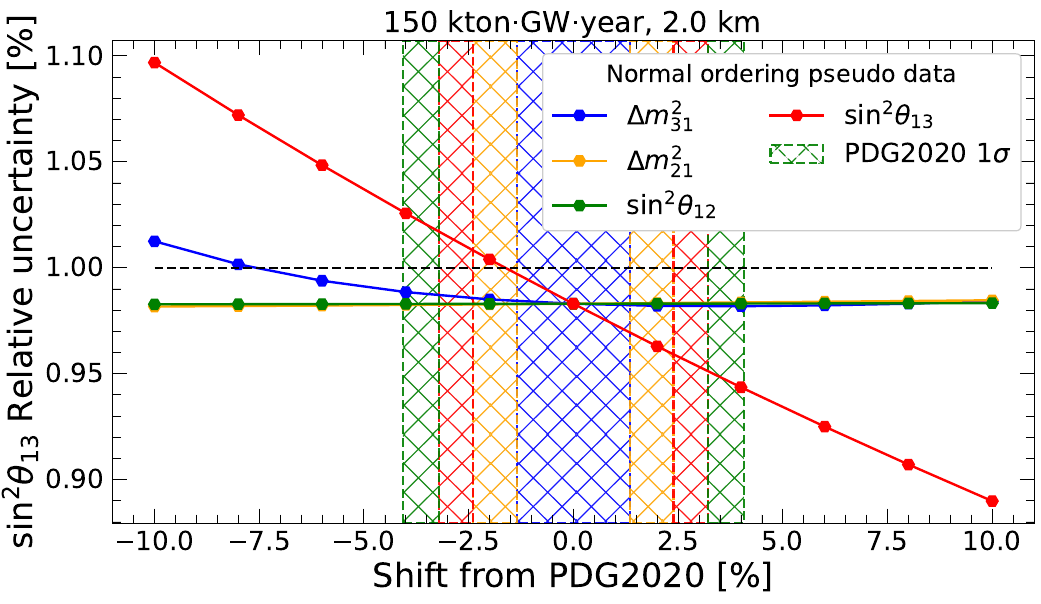
Figure 6 . The sin 2 θ 13 precision measurement sensitivity for the Asimov pseudo data generated with the oscillation parameters shifted from PDG2020 [4]. The green and orange lines are on the top of each other since the roles of sin 2 θ 12 and ∆ m 2 true values are almost the same for the 21 sin 2 θ 13 measurement. The shadow area represents the 1 σ region given in PDG2020. The normal and inverted ordering hypotheses yield almost the same results. It can be seen that the true value of sin 2 θ 13 has more impact than all other oscillation